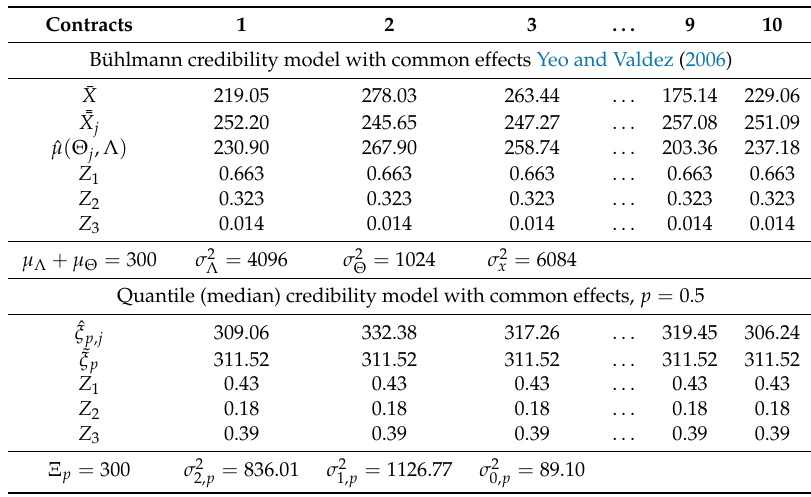
Table 3. Credibility premiums